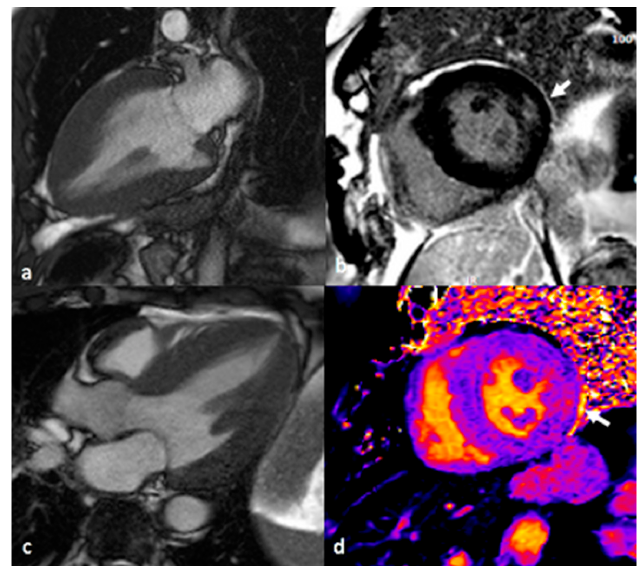
Figure 3. Panel of cardiac MRI images. Image ( a ), vertical long axis view of the left ventricle acquired using a balanced steady-state free procession sequence in end-diastole demonstrating significant left ventricular hypertrophy. Image ( b ), short axis view acquired in the late phase following Gadolinium administration using a phase sensitive inversion recovery imaging acquisition. The arrow demonstrates significant non-ischaemic enhancement and fibrosis of the basal lateral and basal inferolateral wall segments. Image ( c ), three chamber view acquired using a balanced steady-state free procession imaging sequence in end-diastole demonstrating significant left ventricular hypertrophy. Image ( d ), native T1 map acquired in the basal short axis using a modified Look-Locker Imaging (MOLLI) sequence. Arrow demonstrates an area of elevated native T1 values in the region of the basal inferolateral wall segments (1019 ms) compared to the low T1 native valves in the basal inferoseptum (880 ms).